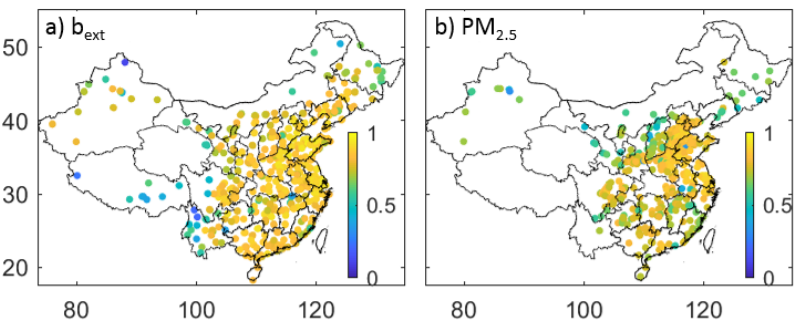
Figure 3. Spearman correlation coefficient ( ρ ) between stations with a distance of less than 50 km for PM 2.5 ( b ) and b ext ( a ).